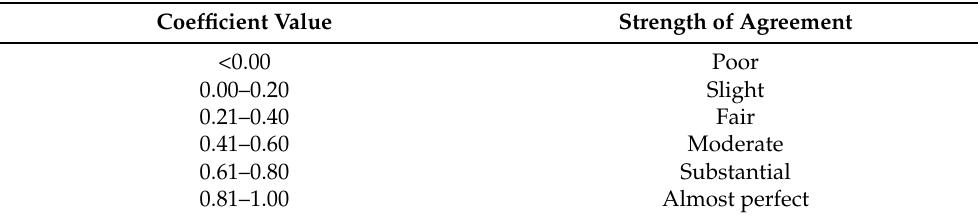
Table 3. Interpretation of kappa coefficient